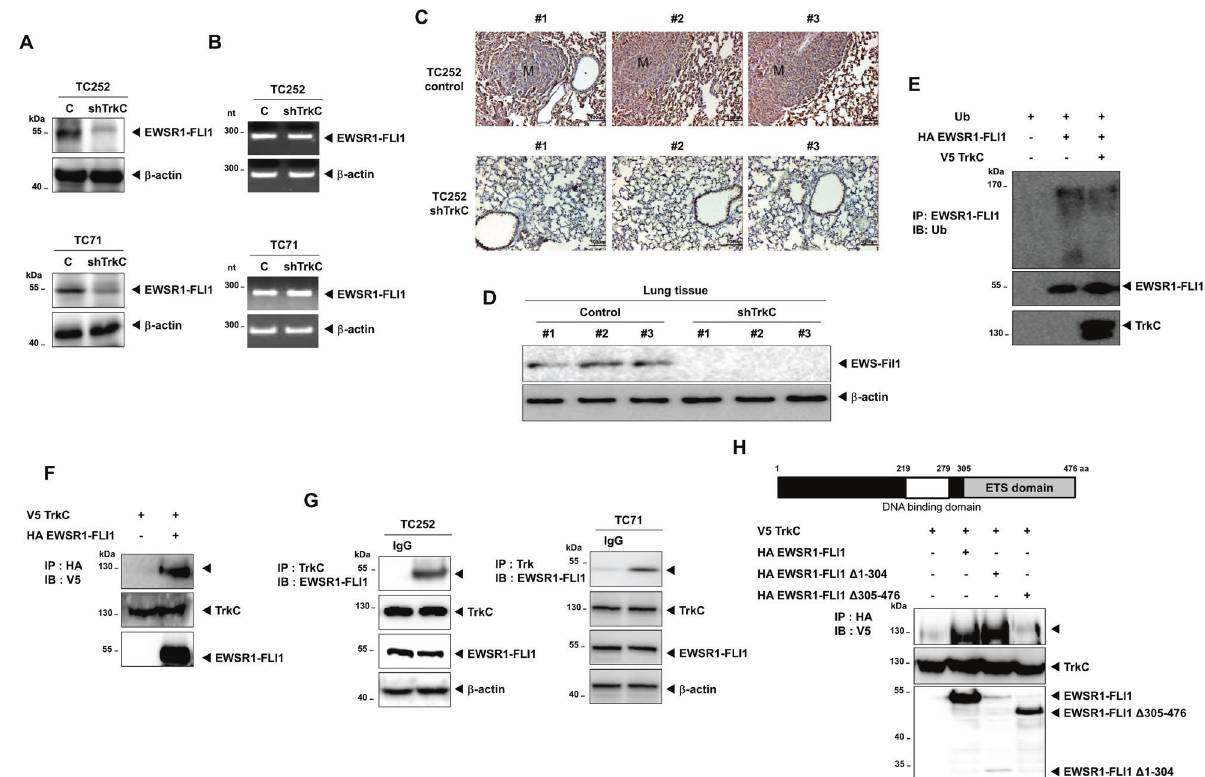
Fig. 7 TrkC stabilized EWSR1-FLI1 by inhibiting its proteasomal degradation. A Immunoblot analysis of EWSR1-FLI1 in TC252 and TC71 control-shRNA or TrkC-shRNA cells. β -actin was used as a loading control. B RT-PCR analysis of EWSR1-FLI1 in TC252 and TC71 control-shRNA or TrkC-shRNA cells. β -actin was used as a loading control. C Representative immunohistochemical images presenting the expression of EWSR1- FLI1 in the lungs excised from individual mice expressing either TC252 control-shRNA or TrkC-shRNA. M, metastatic nodule. D Immunoblot analysis of EWSR1-FLI1 in tumor cells recovered from the lungs of individual mice expressing either TC252 control-shRNA or TrkC-shRNA. β -actin was used as a loading control. n = 3. E Immunoblot analysis of whole-cell lysates and immunoprecipitates derived from 293T cells transfected with the ubiquitin, HA-EWSR1-FLI1, and V5-TrkC constructs, as indicated. F Identi fi cation of the complex formation of TrkC/EWSR1- FLI1. Immunoblot analysis of whole-cell lysates and immunoprecipitates derived from 293T cells transfected with the V5-TrkC and HA-EWSR1- FLI1 constructs, as indicated. G Identi fi cation of an endogenous TrkC-EWSR1-FLI1 complex in TC252 cells. Cell lysates were subjected to immunoprecipitation using an anti-IgG or anti-TrkC antibody, followed by immunoblotting with anti-FLI1 and anti-TrkC antibodies. β -actin was used as a loading control. H Identi fi cation of the region of EWSR1-FLI1 responsible for its interaction with TrkC. Immunoblot analysis of whole- cell lysates and immunoprecipitates derived from 293T cells transfected with the V5-TrkC and HA-EWSR1-FLI1 deletion